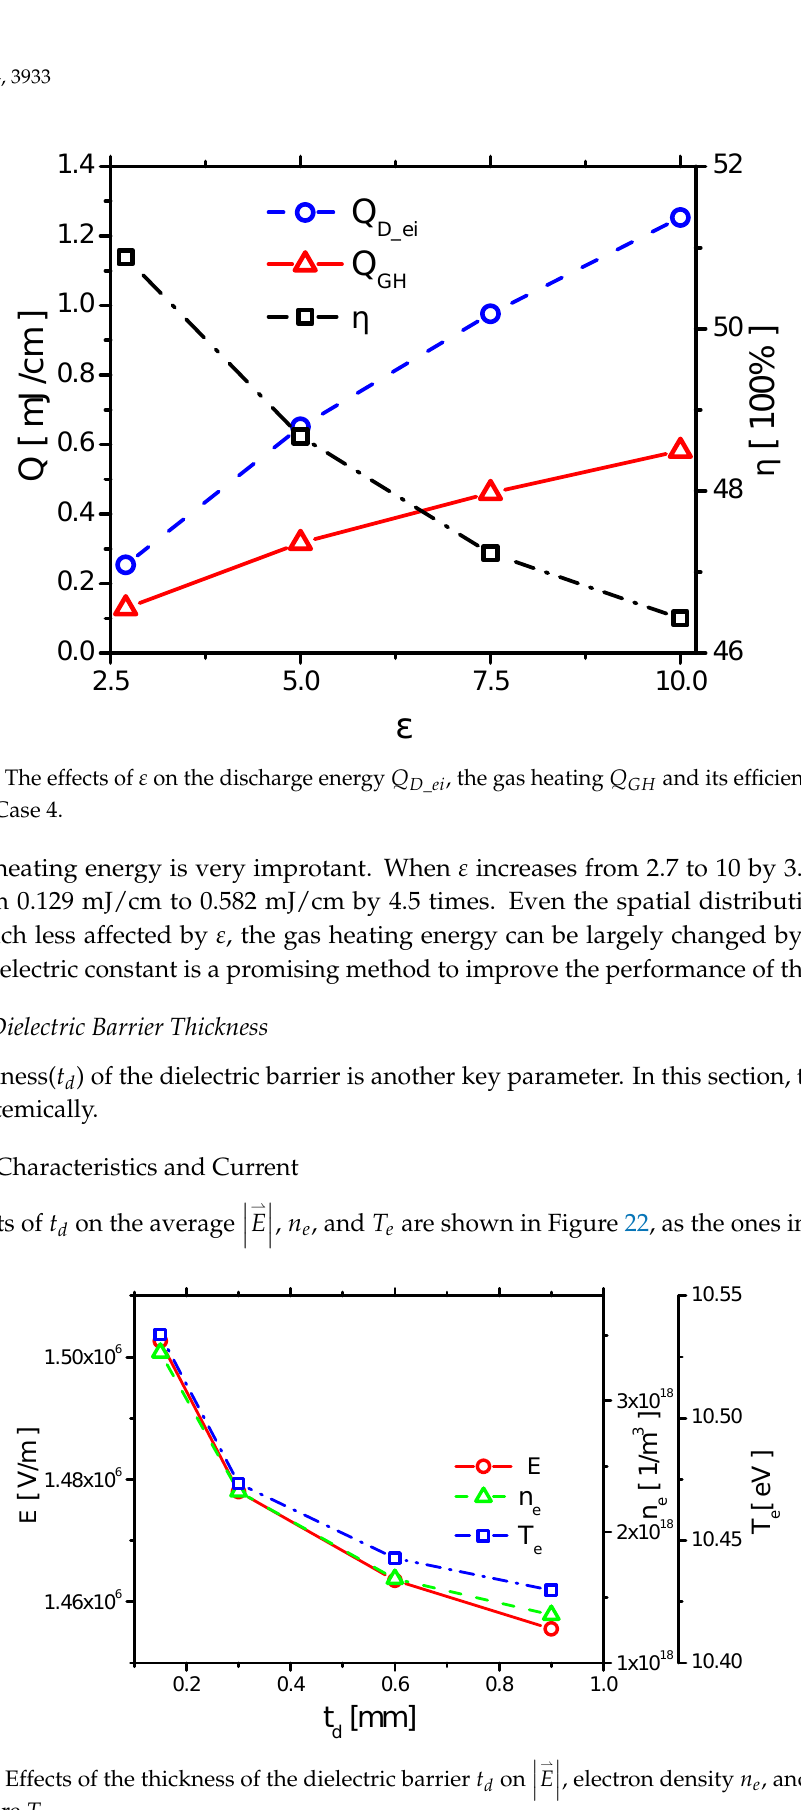
Figure 22. Effects of the thickness of the dielectric barrier t d on temperature T e